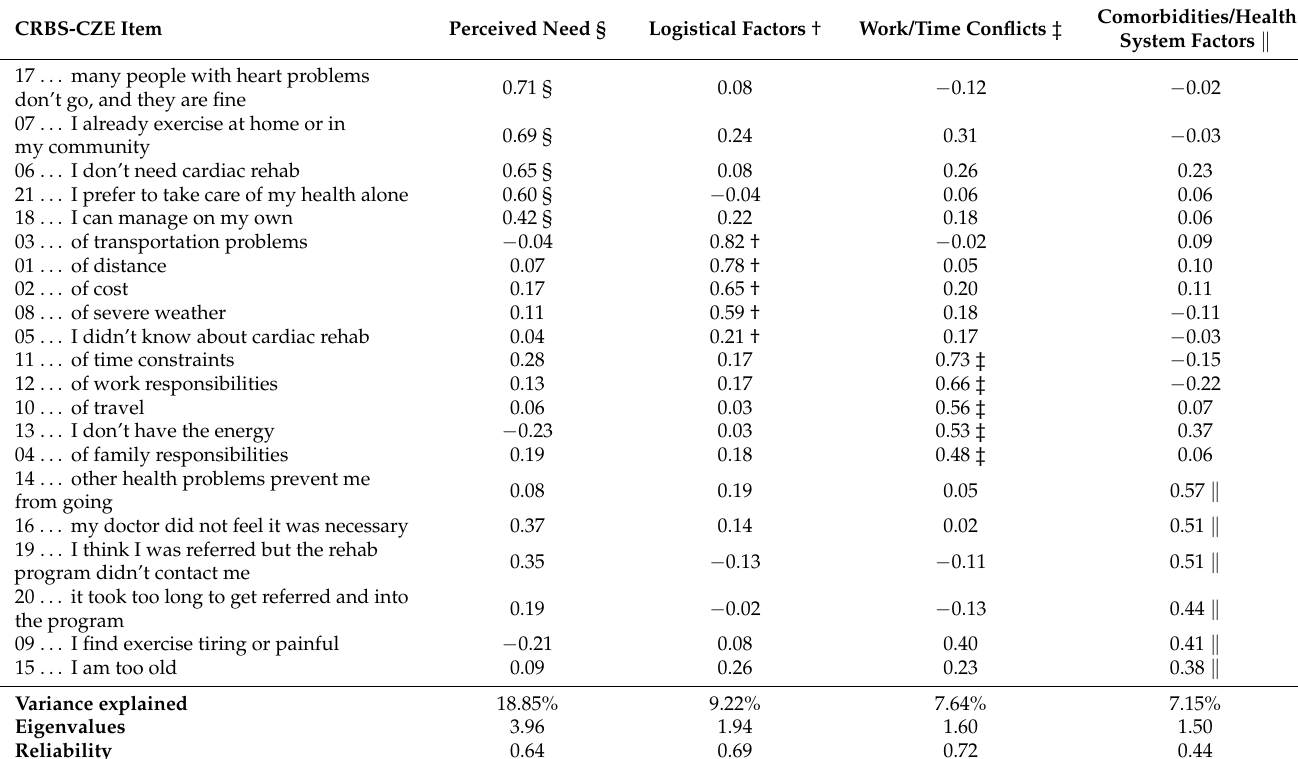
Table 3. Principal components factor analysis results ( n = 186).